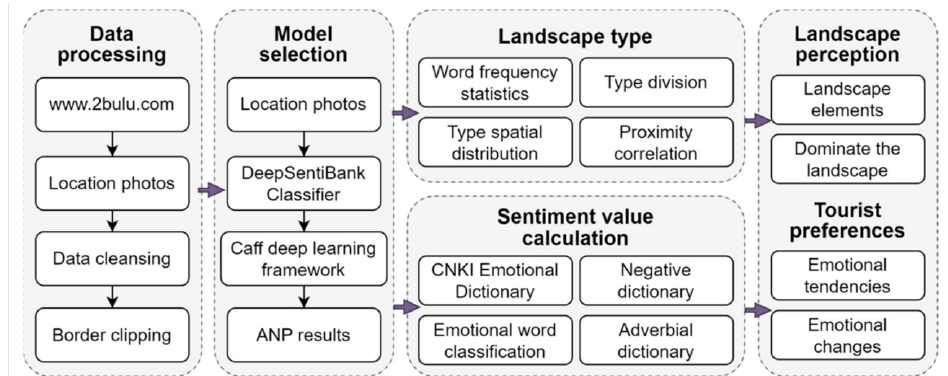
Figure 2. Research framework for visual perception and the emotional analysis of tourists (https: //www.2bulu.com/ accessed on 6 December